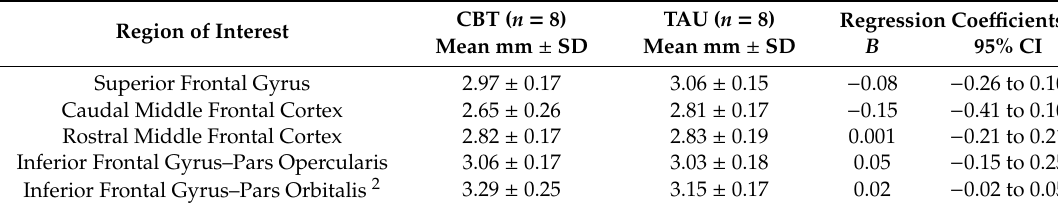
Table 4. Average MRI-derived Local gray matter thickness di ff erences in the left hemisphere in children aged approximately six years in a longitudinal study, built on a pilot Randomized Controlled Trial, comparing Cognitive Behavioral Therapy (CBT) and Treatment as Usual (TAU) for maternal antenatal